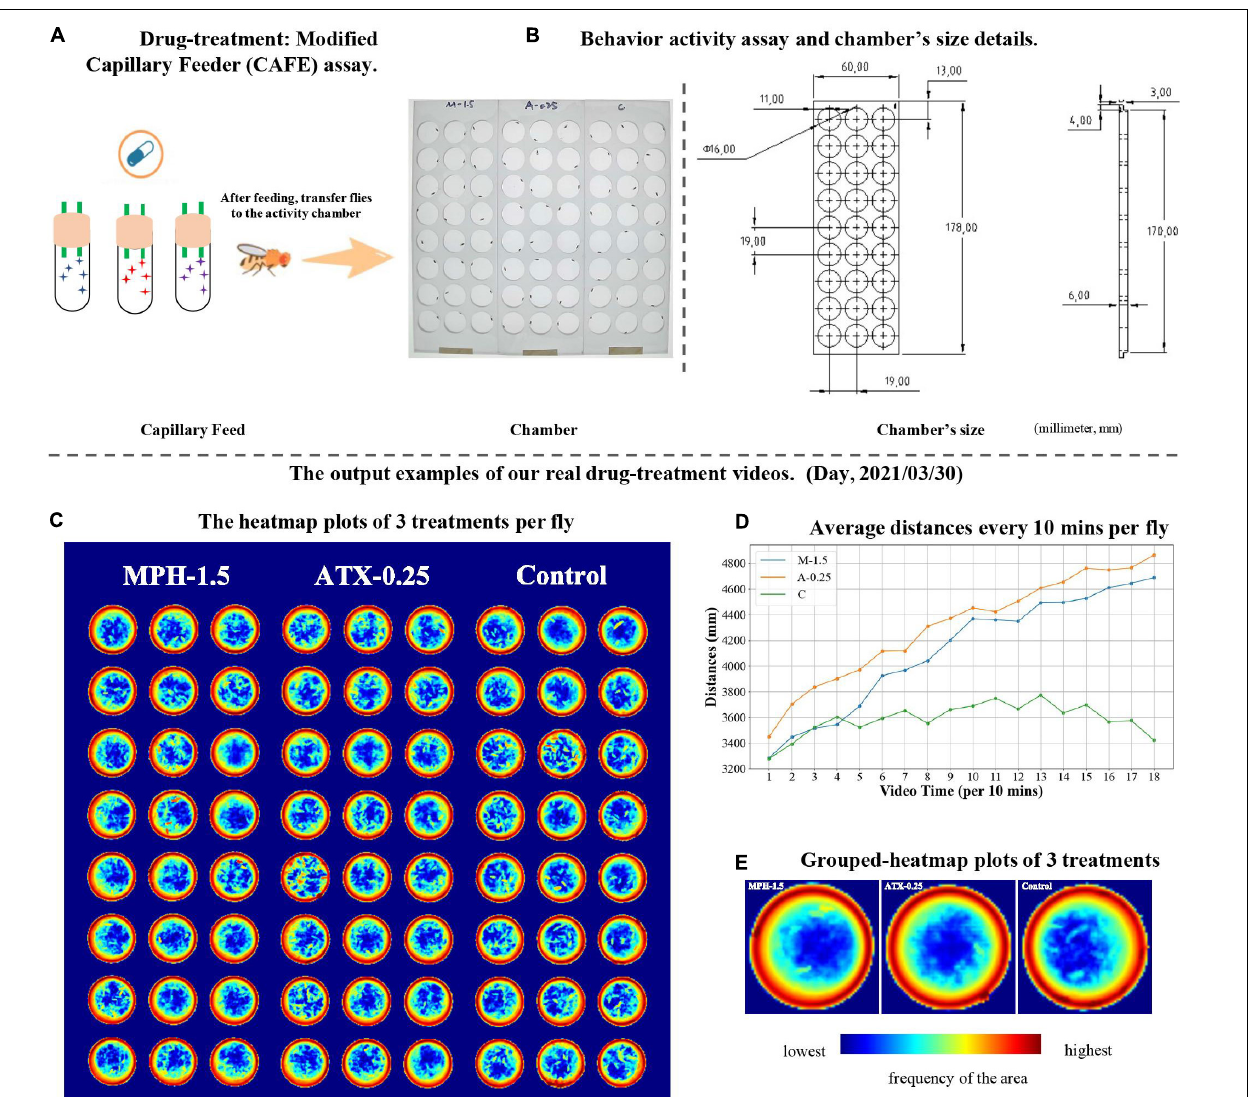
FIGURE 4 | An example of psychiatric drug treatment study using EasyFlyTracker. (A) Drug treatment by modified capillary feeder (CAFE) assay. (B) Example of activity assay and size of chambers for the three treatments. Panels (C–E) plots are output examples of our real drug treatment video, which was taken on March 30, 2021. (C) Heatmap plot of the frequency of each fly. The relative frequency of the fly passage at each location was plotted (red indicates the highest frequency in the area; dark blue indicates that no flies ever transitioned through this position). (D) The average distance every 10 min per fly was significantly increased in the methylphenidate (MPH) (M-1.5)- or atomoxetine (ATX) (A-0.25)-exposed group compared to the control (C) group throughout the 3-h video. (E) Grouped-heatmap plots of three treatments. The color legend is the same as in (C)